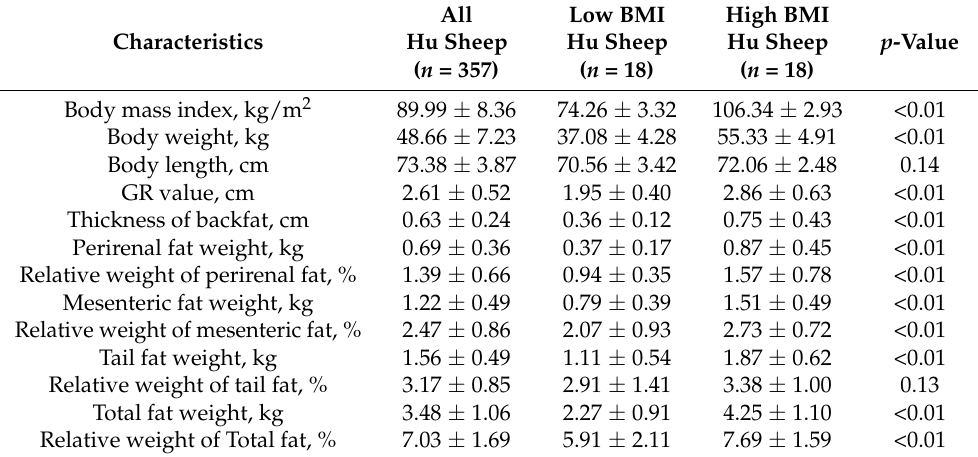
Table 2. Description of fat traits and grouping difference test of high- and low-BMI Hu sheep.